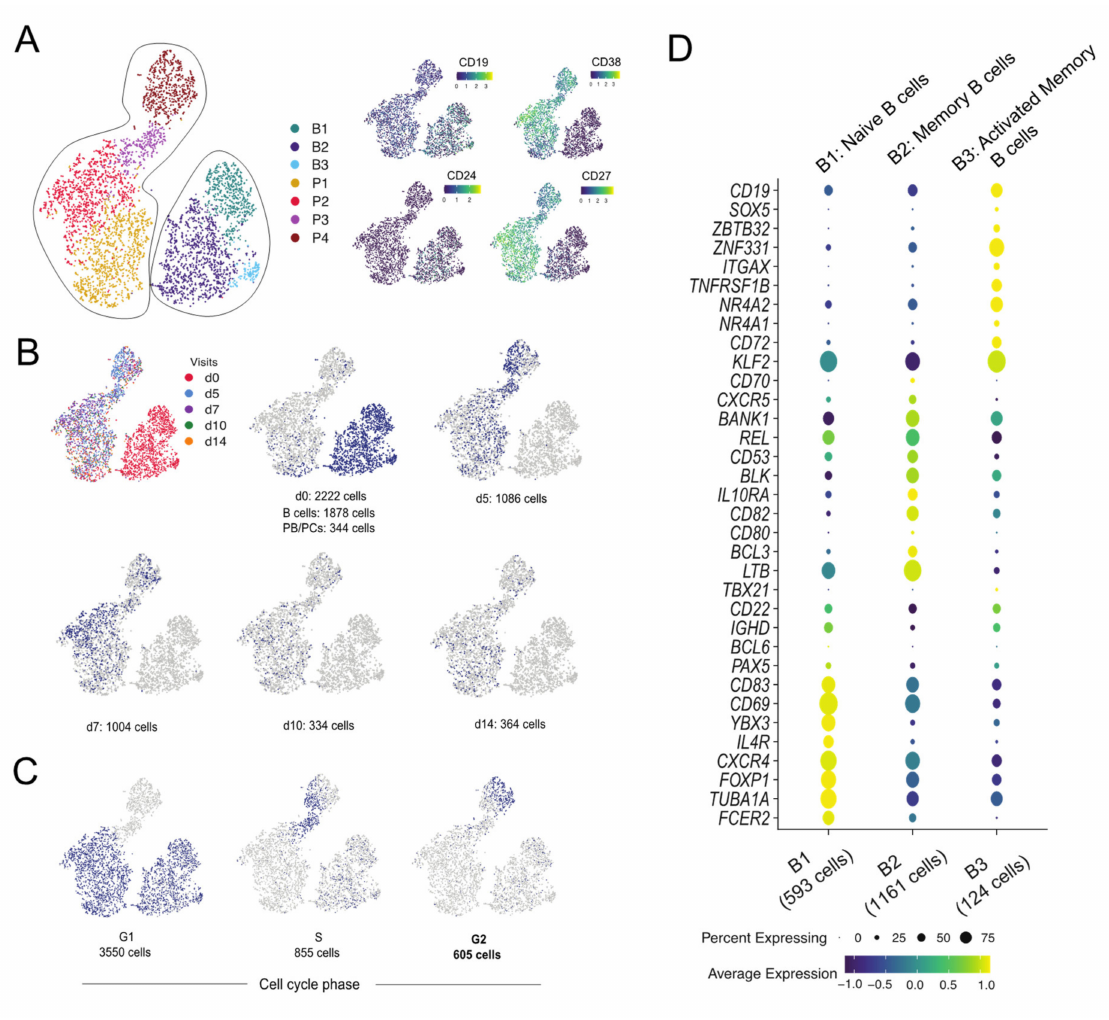
Figure 1. Identification of B-cell subpopulations by single cell-transcriptomics analysis. ( A ) The clusters of cells are represented on a tSNE plot based on the highly variable genes. The clusters are named as B1-B3 for B cells and P1-P4 for PB/PCs. The expression of the markers used for sorting the cells in the study is plotted on the tSNE plot. High expression of CD38 and CD27 marks the clusters P1-P4 as the PB/PCs. ( B ) Plotting tag information on the tSNE plot. The cells are assigned to each visit and cells at d0 are assigned to B cells and PB/PCs based on their location in B1-B3 and P1-P4 clusters, respectively. ( C ) Visualizing cell cycle scores on tSNE plot. G1, S and G2M cell-cycle scores are represented on the tSNE plot where P3 and P4 clusters comprise of S and G2M phase cells. ( D ) Dot plot of the gene markers used for identifying the B-cell subpopulations. B1: Naive B cells; B2: Memory B cells; B3: Activated memory B